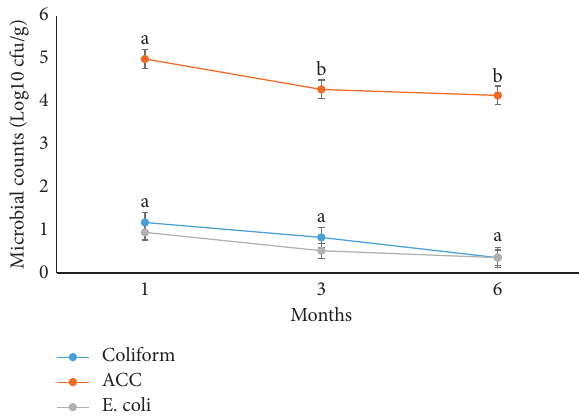
Figure 1: Microbial counts according to cheeses type; for each microbial type, bars with different superscripts are significantly different ( P < 0 . 05). ACC: aerobic colony count; E. coli : Escherichia coli.